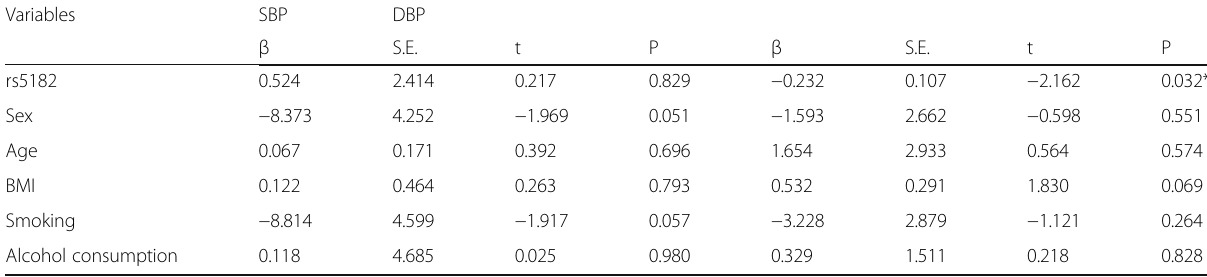
Table 7 Multivariate linear regression analysis of the rs5182 polymorphism with systolic pressure and diastolic pressure Variables SBP DBP β